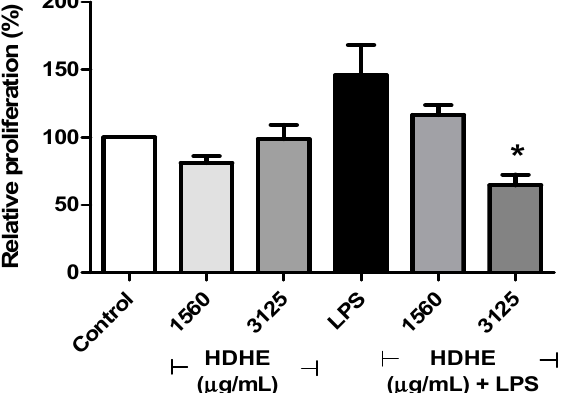
Figure 4. Effect of hydroalcoholic extract from leaves of Himatanthus drasticus on LPS-stimulated proliferation of human PBMC. HDHE: H. drasticus hydroalcoholic extract. * p < 0.05 in relation to LPS-treated PBMC (positive control). The experiment we performed in two independent assays and at least 20,000 cells were analyzed.